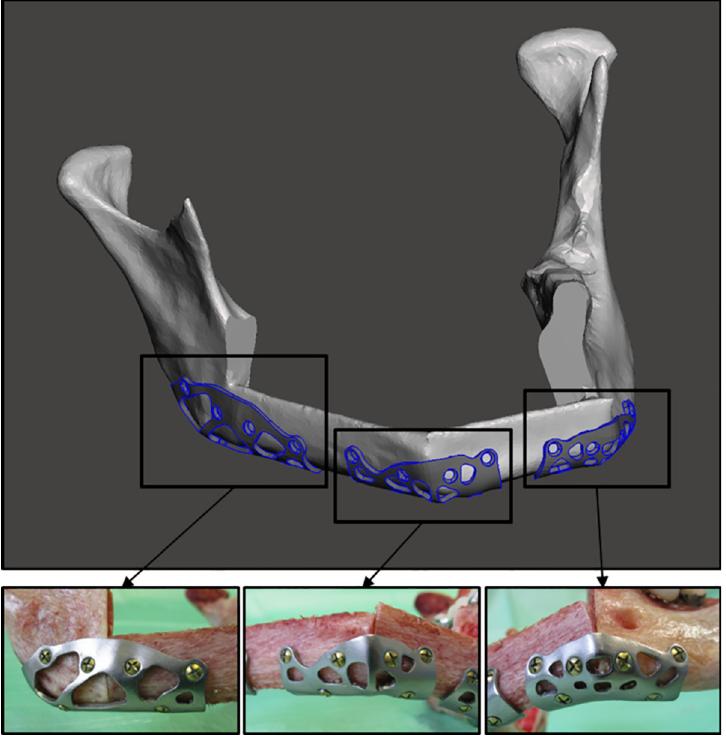
Fig 2. Patient specific, topology optimized osteosynthesis plates (TOPOS-implants). (Top) Virtual planning and fitting of the osteosynthesis plates for the fixation of the fibular segments. (Bottom) Application of the implants to the specimen produced with electron beam